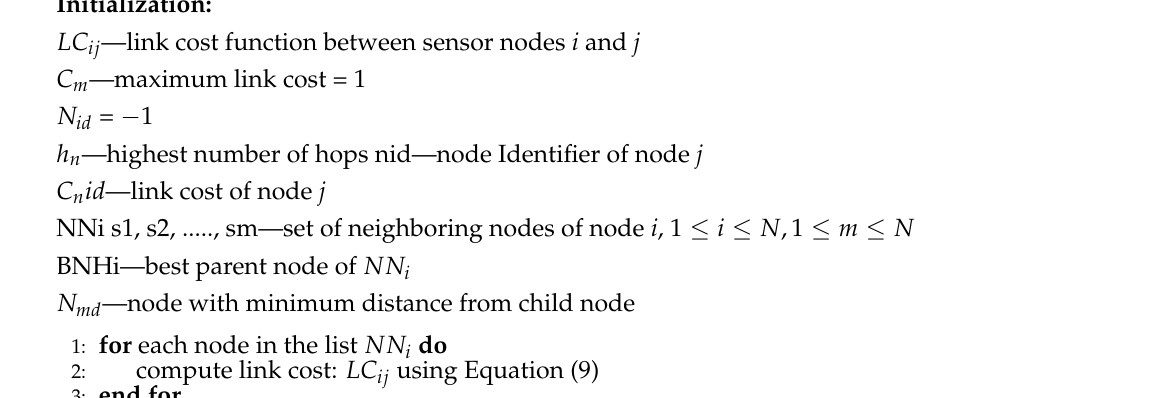
Algorithm 1 Best parent node selection